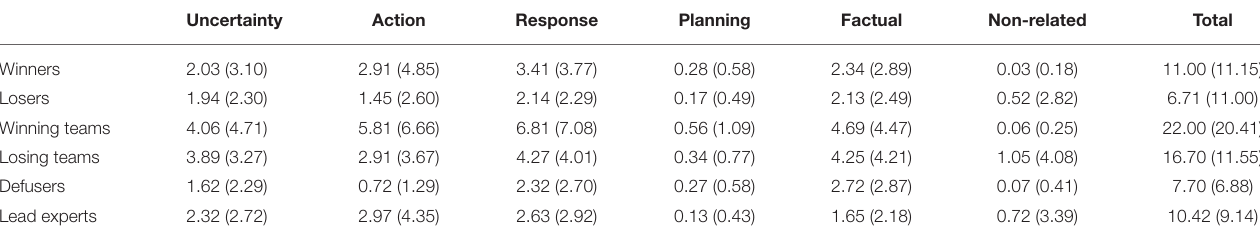
TABLE 6 | Mean (Stdev) of number of times chat categories were used by winners and losers, by winning and losing teams, by Defusers and Lead Experts, and total usage by each.